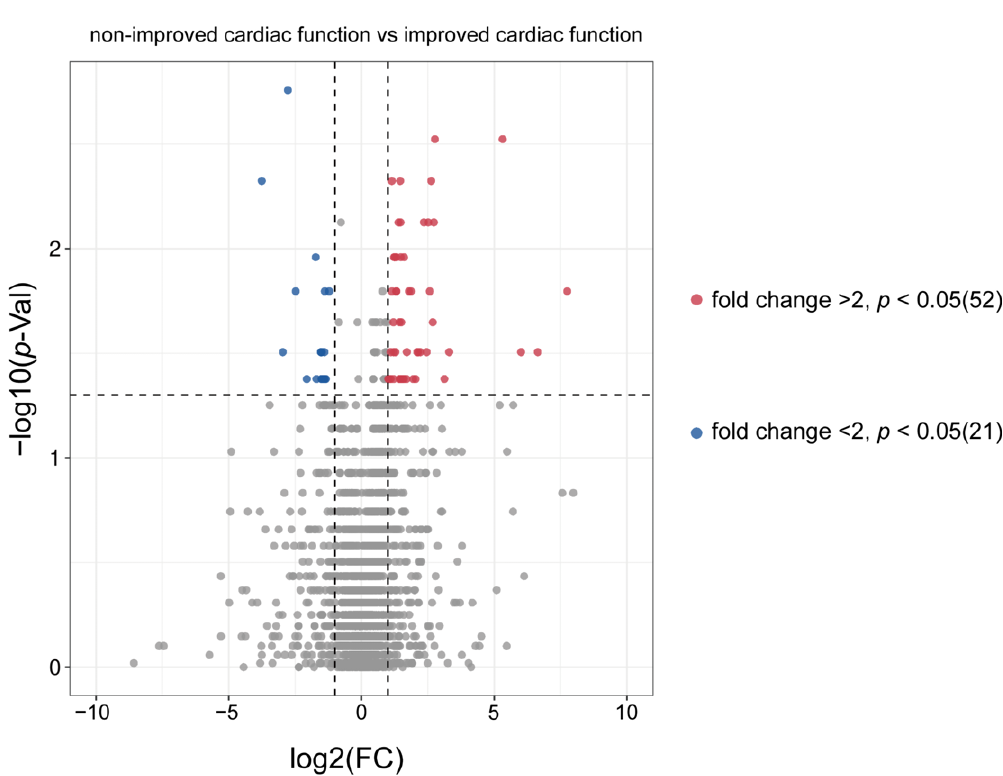
Figure 2. Volcano plot of metabolic profiles in preoperative plasma from non ‐ improved cardiac function patients and improved cardiac function patients: 52 metabolites were significantly ( p < 0.05) upregulated (fold change > 2) in non ‐ improved cardiac function patients and 21 metabolites were significantly ( p < 0.05) downregulated (fold change < 2) in non ‐ improved cardiac function patients.